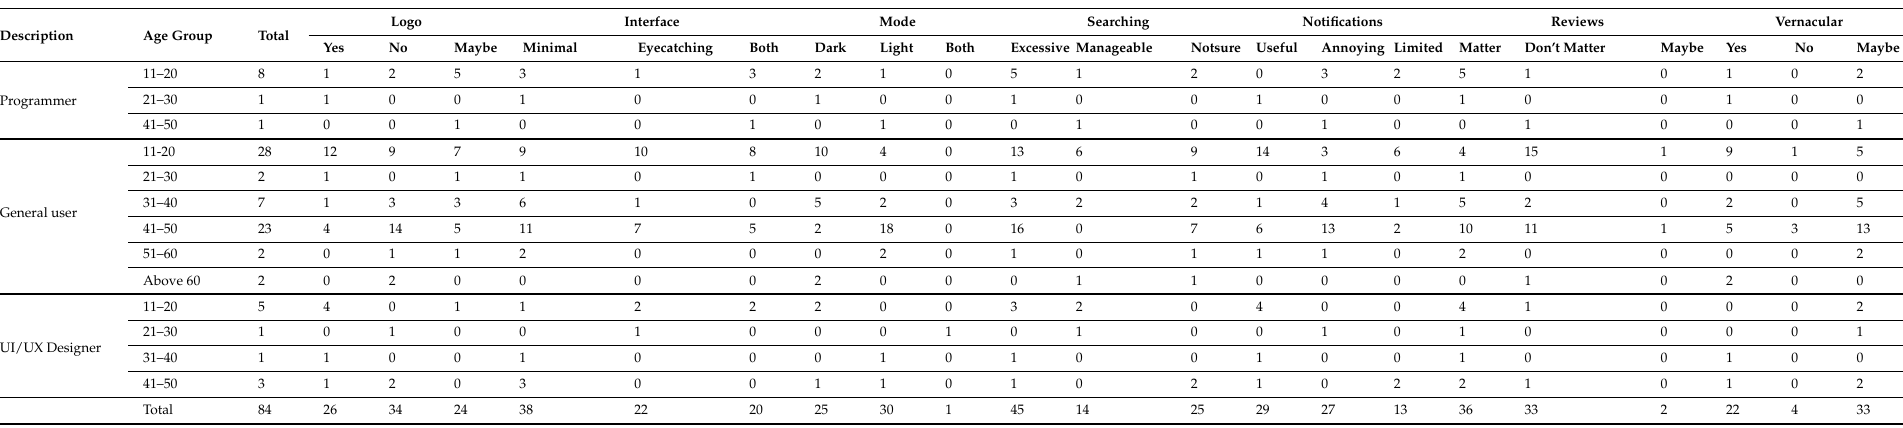
Table 4. Parametric perception data from survey: